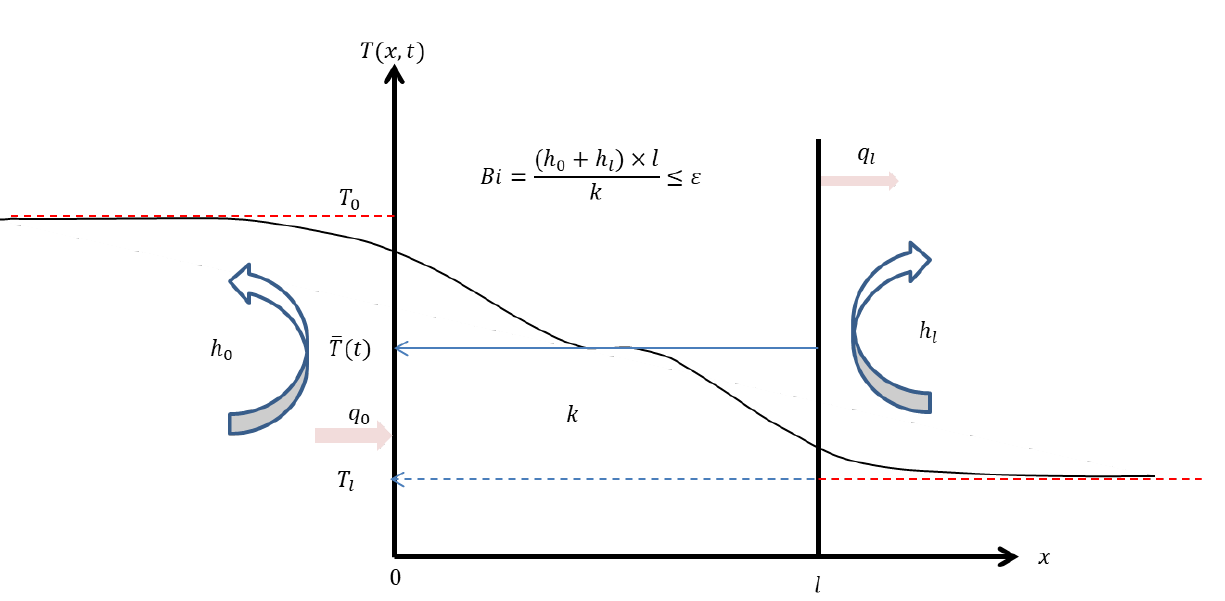
Figure 1. The heat transfer problem presented for a 1D wall.